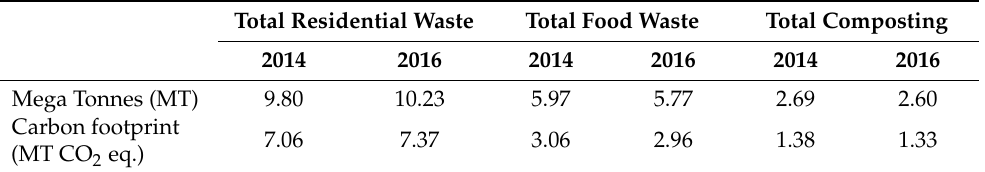
Table 4. Carbon footprint of different waste types. Total Residential Waste Total Food Waste Total